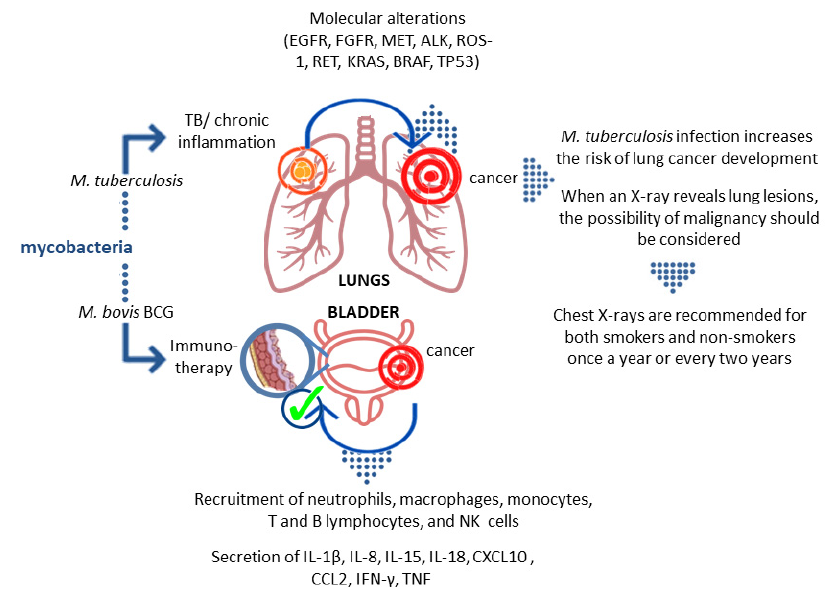
Figure 2. The dual nature of the relationship between mycobacteria and cancer. The risk of tumor development in chronic M.tb infections is believed to be the result of multiple host effector mechanisms at various stages of oncogenesis. On the other hand, the influence of M. bovis BCG on the immune system prevents the development of neoplastic processes and/or increases the effectiveness of cancer therapy.